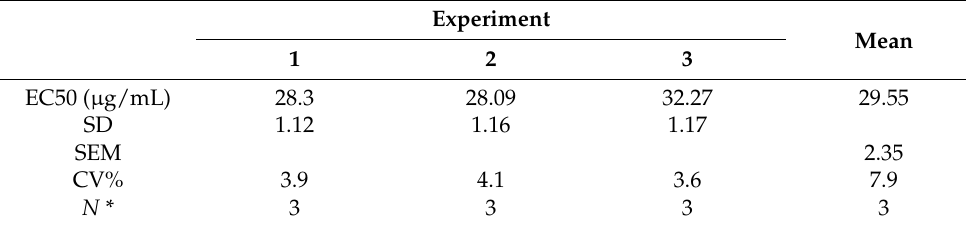
Table 1. Summary of intra-assay and inter-assay variability of EC50 of chimeric anti-CD22 antibod- ies.